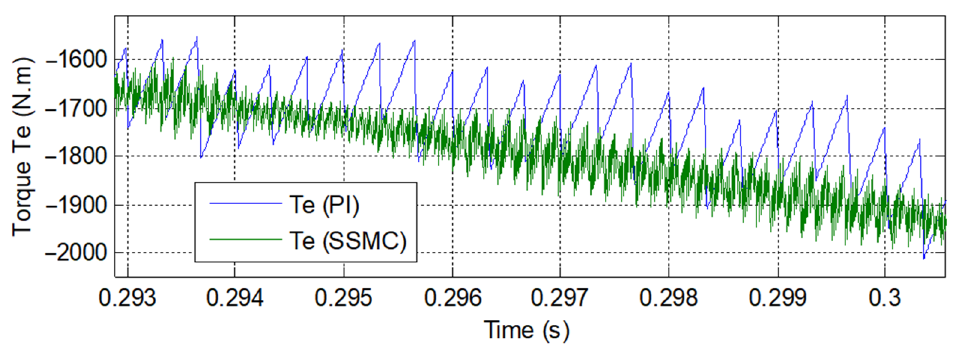
Figure 11. Zoom (Torque).